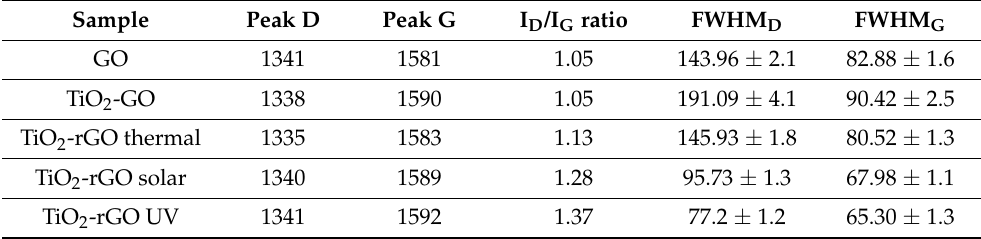
Table 2. Raman signals related to D and G bands obtained by Lorentzian fitting.